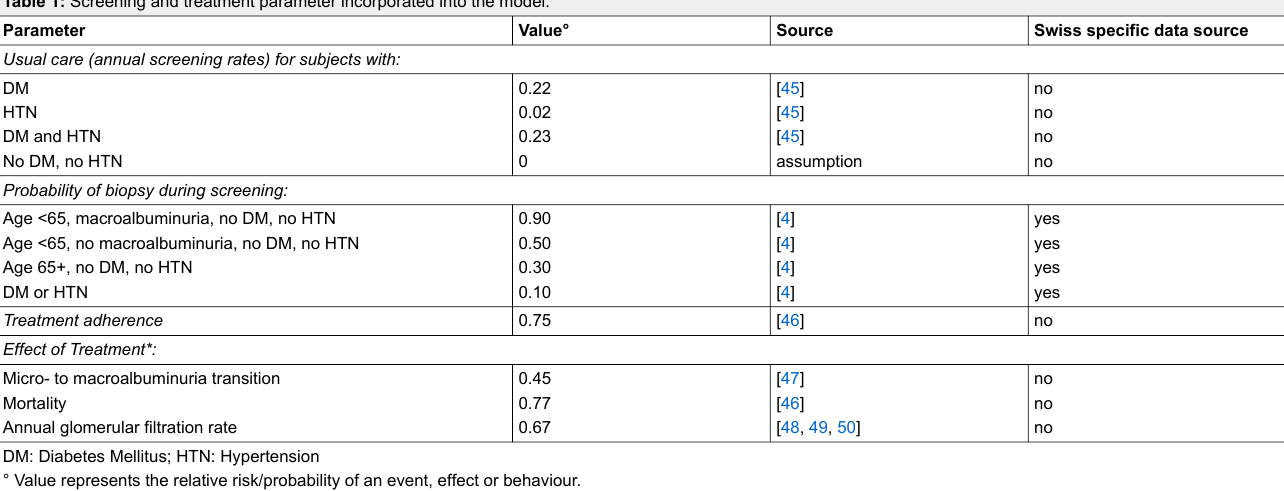
Table 1: Screening and treatment parameter incorporated into the model. Parameter Usual care (annual screening rates) for subjects